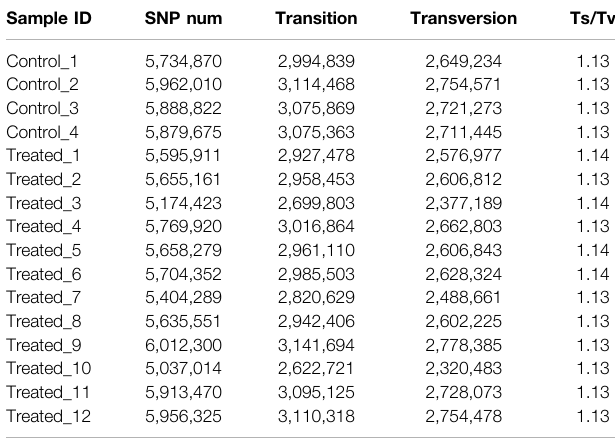
TABLE 4 | SNP information in the control and EMS treatment group after calling. Sample ID